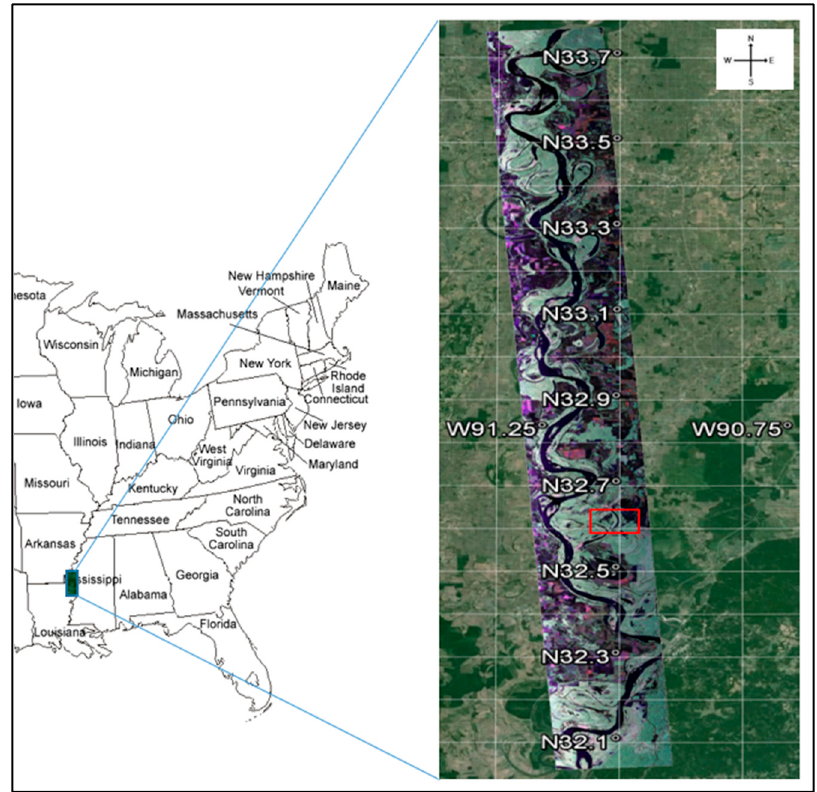
Figure 3. Study area with radar color composite 3 band (HH, VV, & HV) image overlaid on base map.